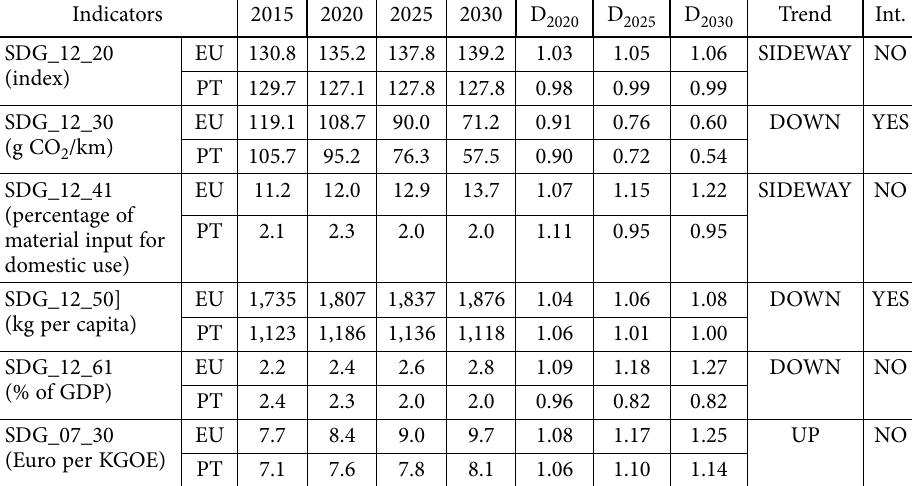
Table 13. SDG 12 – Responsible consumption and production Indicators